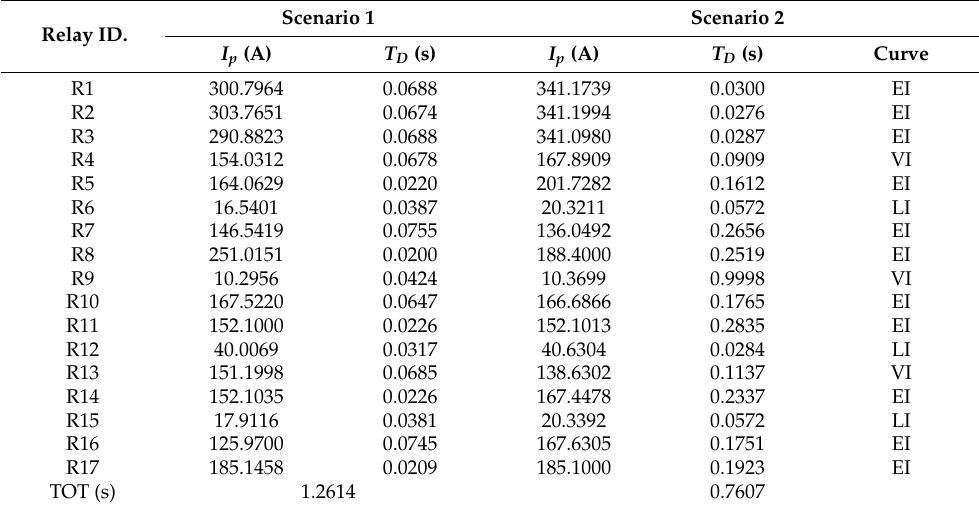
Table 6. OCRs optimum settings of Agiba network using Test Model 2.